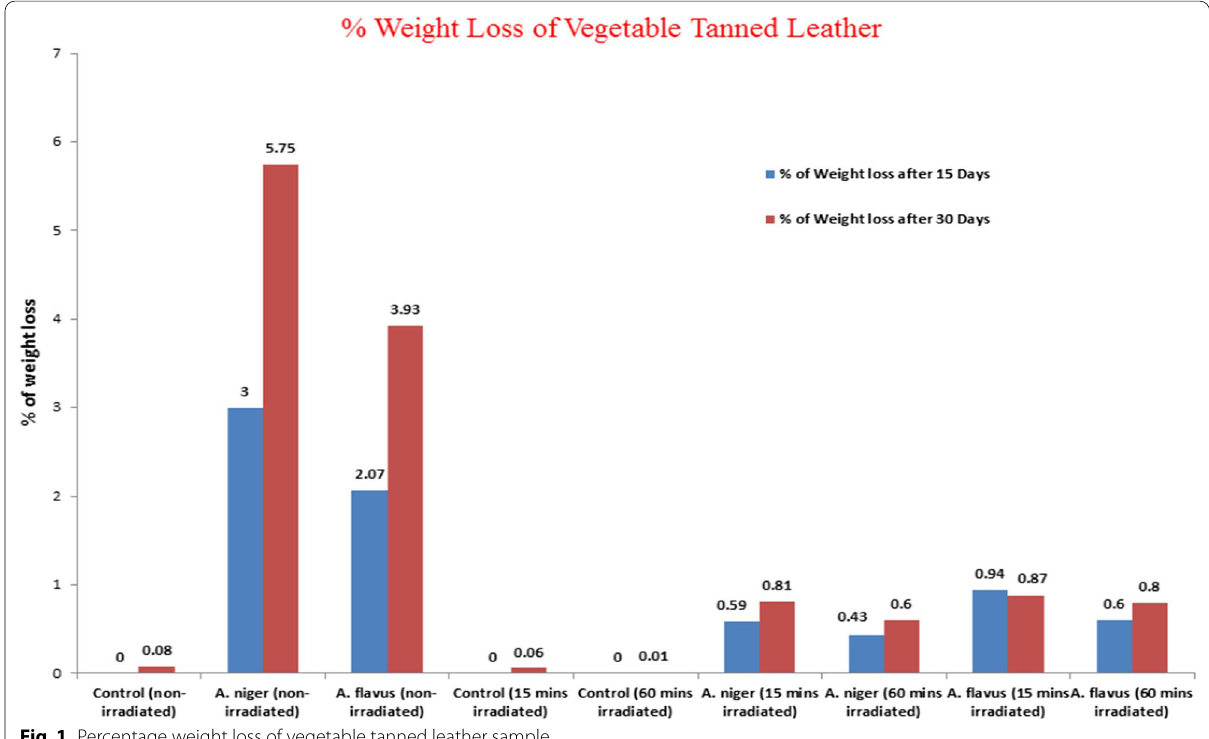
Fig. 1 Percentage weight loss of vegetable tanned leather